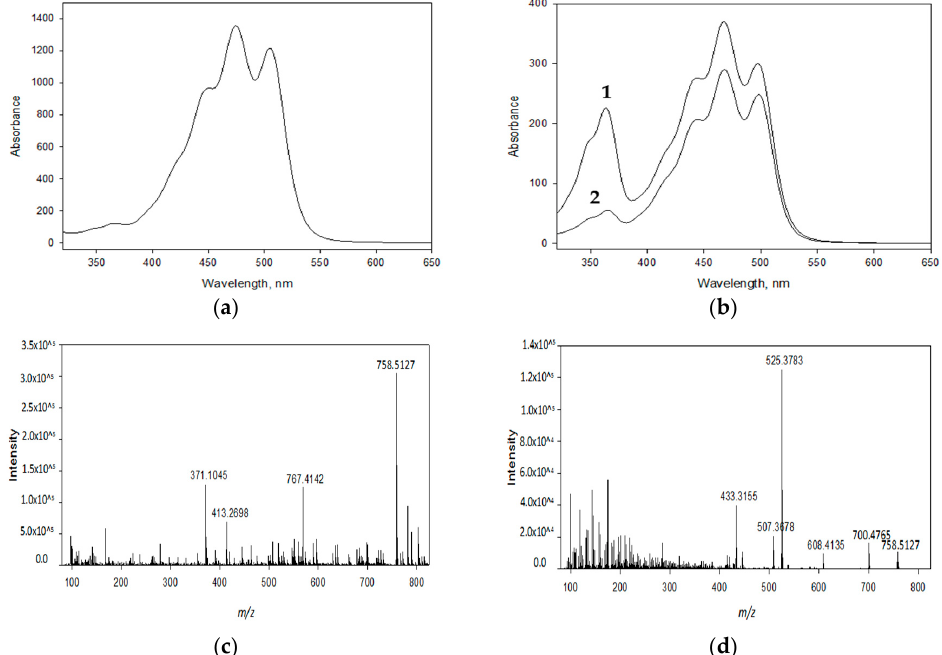
Figure 6. Ultraviolet-visible (UV-Vis) spectra of (all- trans )-myxoxanthophyll obtained by HPCCC ( a ). Ultraviolet-visible (UV-Vis) spectra of 1 (13 or 13 ′ - cis )-myxoxanthophyll and 2 (9 or 9 ′ - cis )-myxoxanthophyll ( b ). High-resolution mass spectrometry with electrospray ionization (ESI) source (ESI-HR/MS) spectrum of (all- trans )-myxoxanthophyll ( c ). High-resolution tandem mass spectrometry with electrospray ionization source (ESI-HRMS/MS) spectrum of the molecular ion of (all- trans )-myxoxanthophyll ( d ).